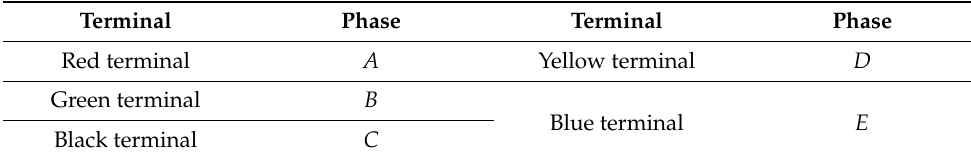
Table 3. The obtained sequence of